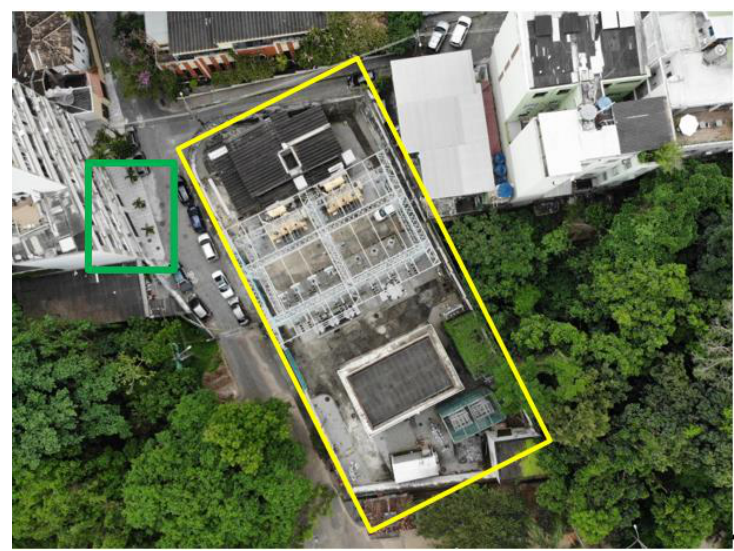
Figure 1. Location of the substation (in yellow) and the source of the complaint (in green).